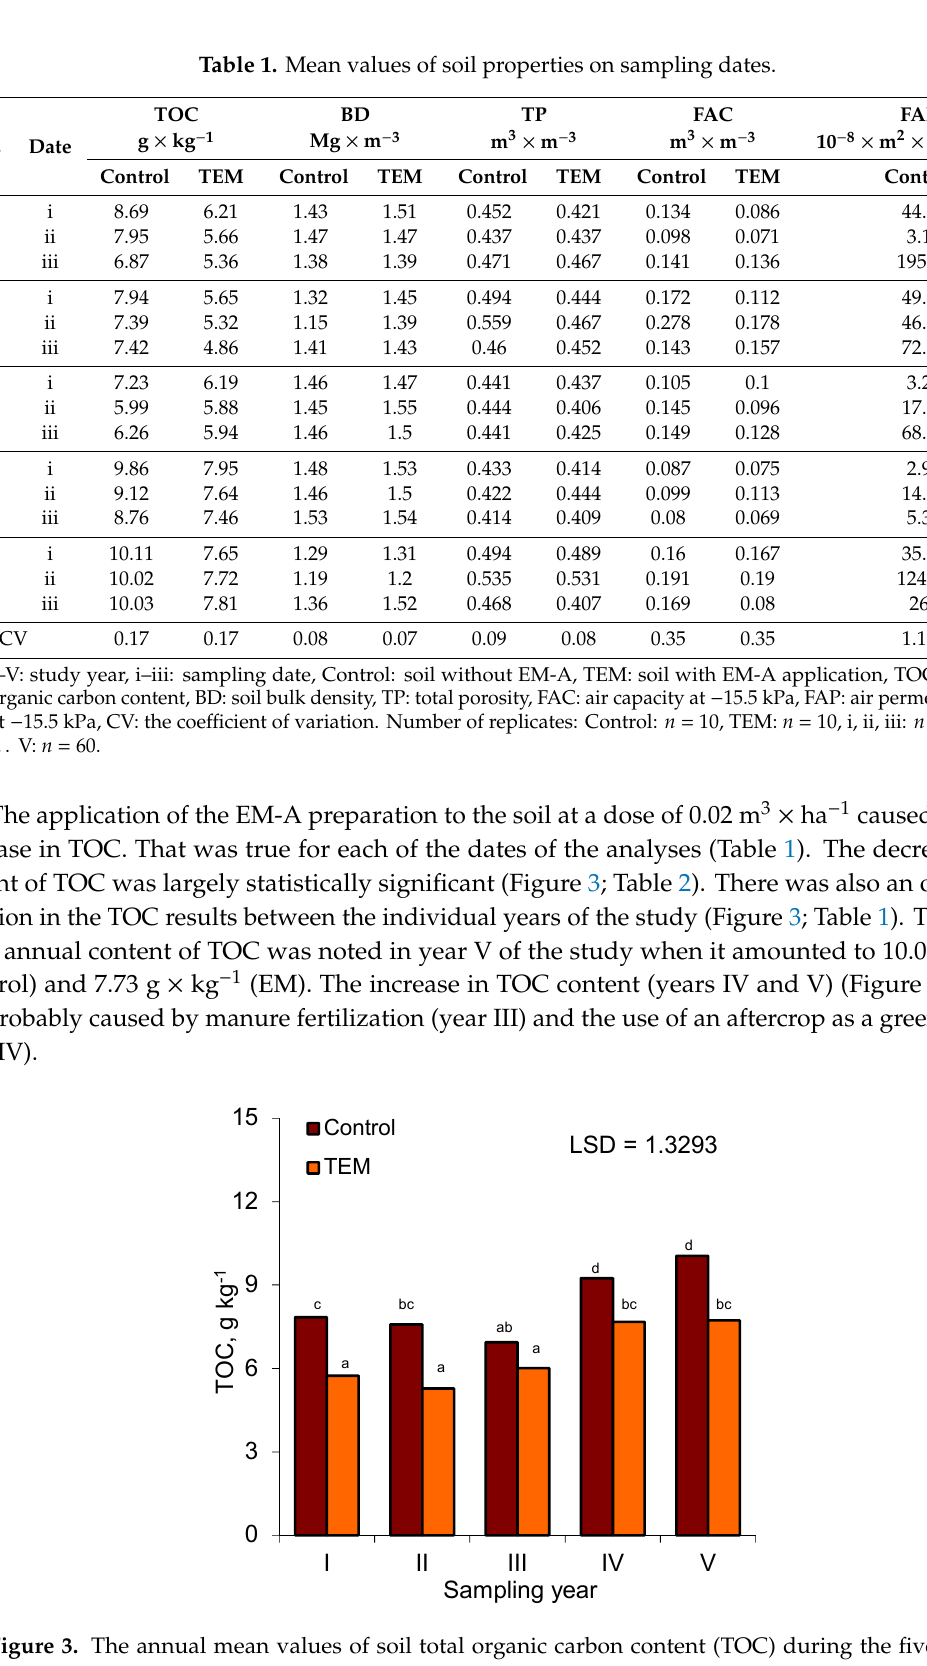
Figure 3. The annual mean values of soil total organic carbon content (TOC) during the